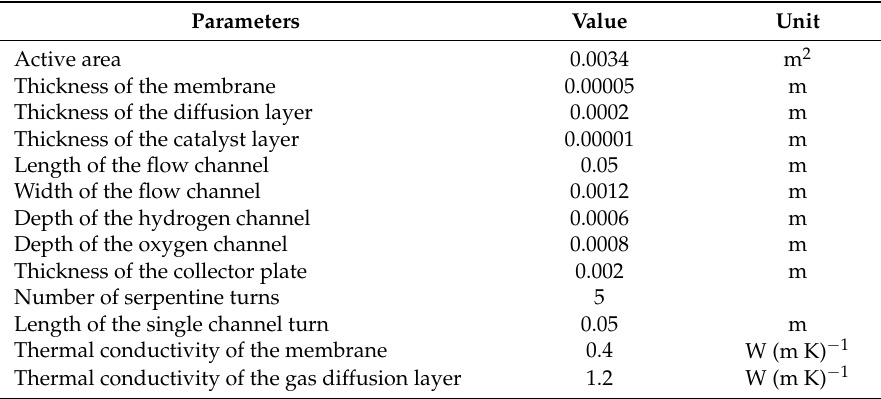
Table 1. Parameters in the anode relative humidity (ARH)